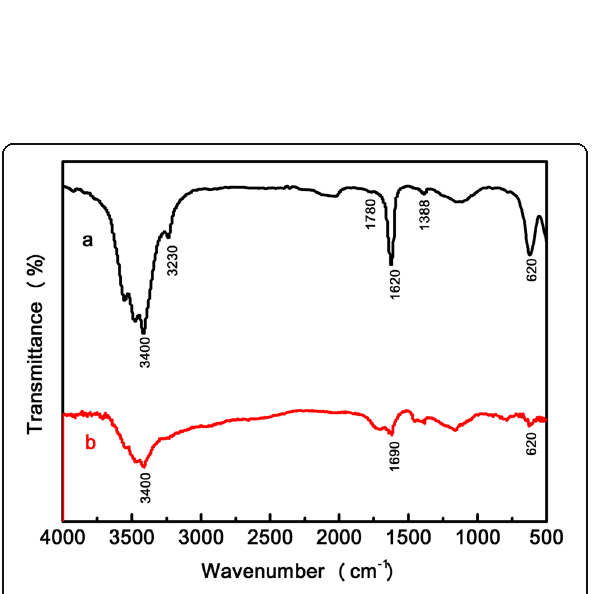
Fig. 1 FTIR spectra of a a composite hydrogel and b a PAA hydrogel